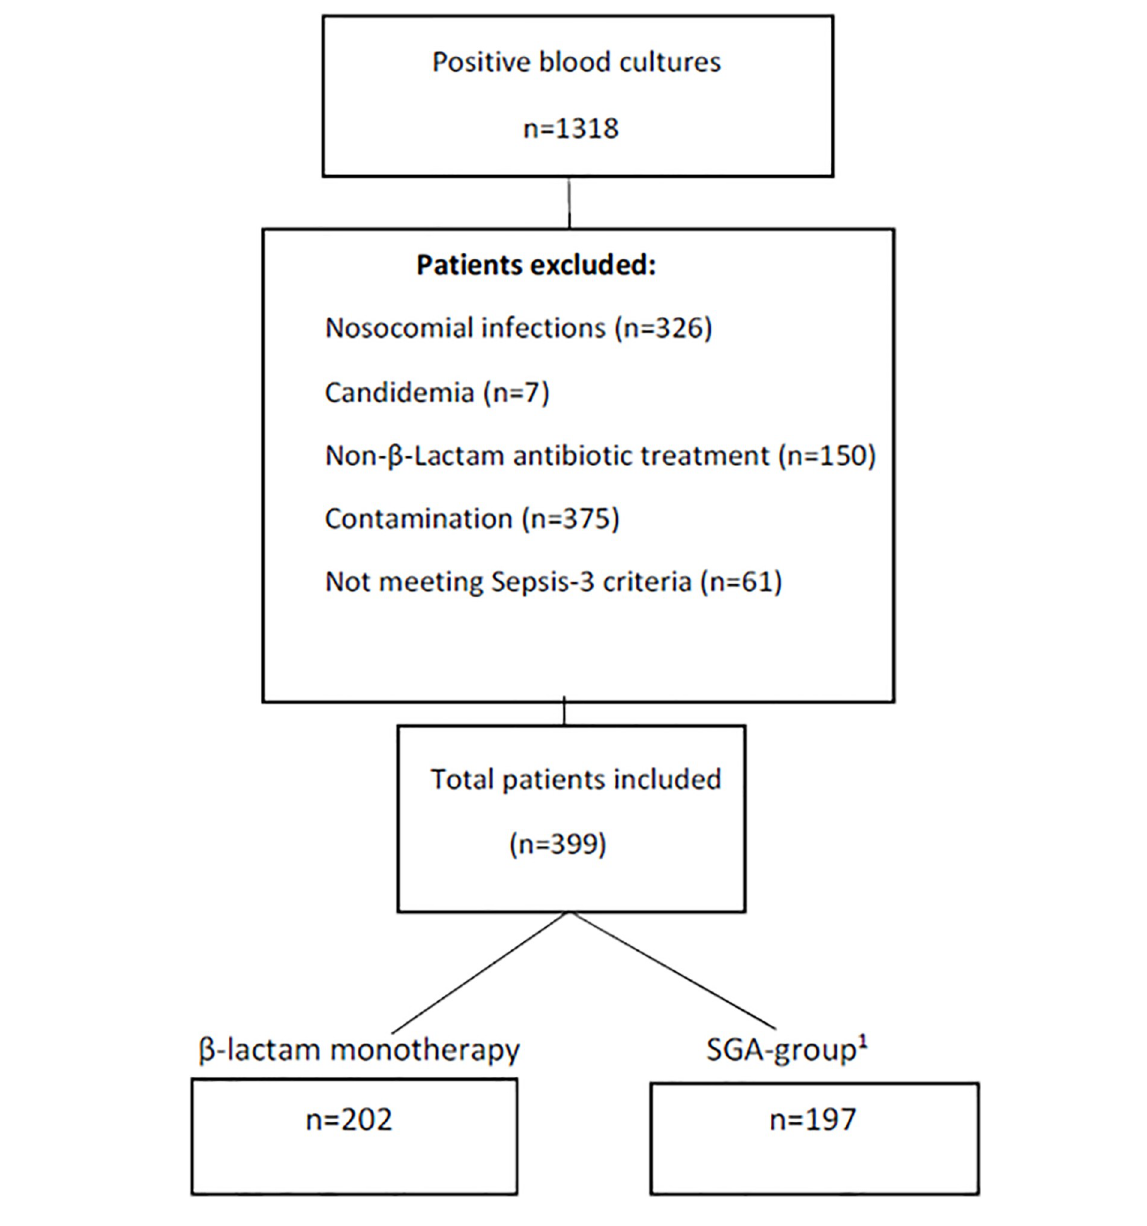
Fig 1. Inclusion flow chart. according to current international guidelines as decreased kidney function measured in glo- merular filtration rate (GFR) of < 60mL per 1.73m2, of at least 3 months duration [33]. Neu- tropenia (defined as neutrophil granulocyte count < 0.5 × 10 9 /L), chemotherapy, steroid treatment (equal of Prednisolone � 20 mg/day), and immune modulatory treatment were con- sidered immune suppression.